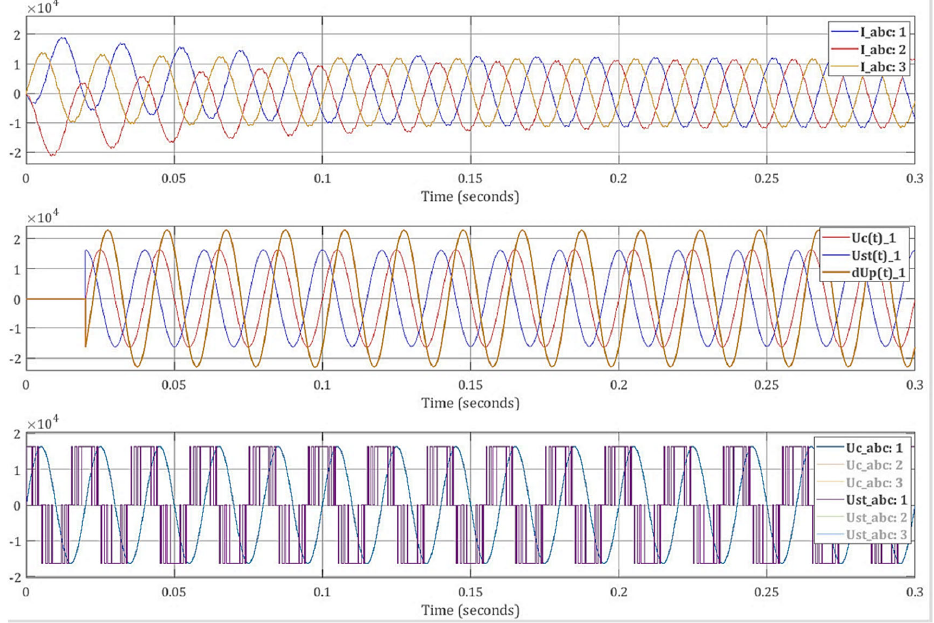
Figure 9. α = 90°, kUst = 1—active power generation and reactive power consumption. Figure 9. α = 90 ◦ , kUst = 1—active power generation and reactive power